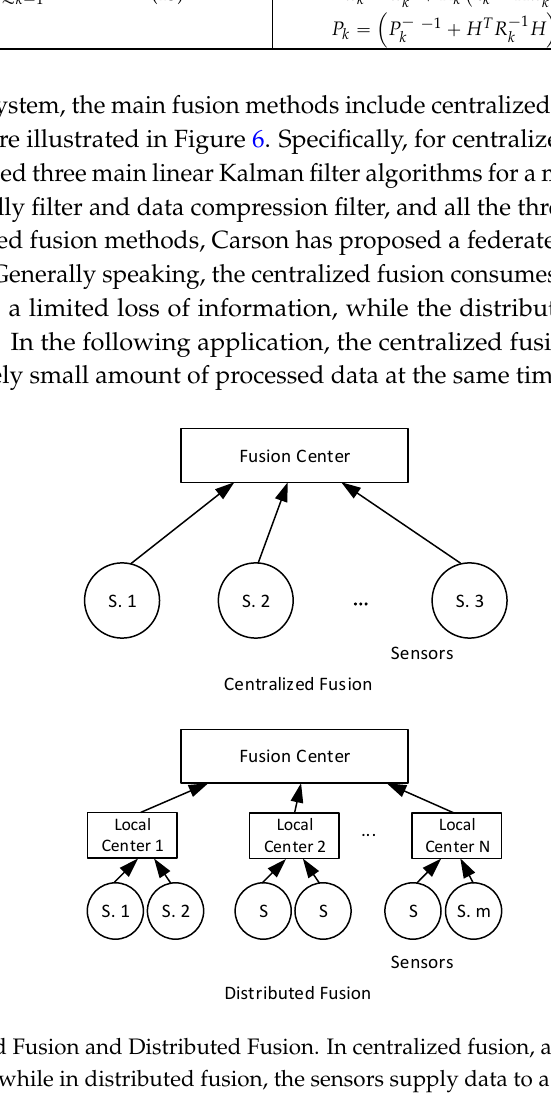
Figure 5. Kalman Filter Predictor-Corrector Cycle. The time update projects the current state estimate ahead, and then the measurement update adjusts the projected estimate based on the actual measurement. Table 2. Kalman Filter Update Equations ( ˆ x ´ —A priori state estimate at step k , P ´ —A priori estimate k k error covariance at step k , ˆ x k —A posteriori state estimate at step k , P k —A posteriori estimate error covariance at step k , K k —Kalman Gain that is deduced by minimizing P k ).